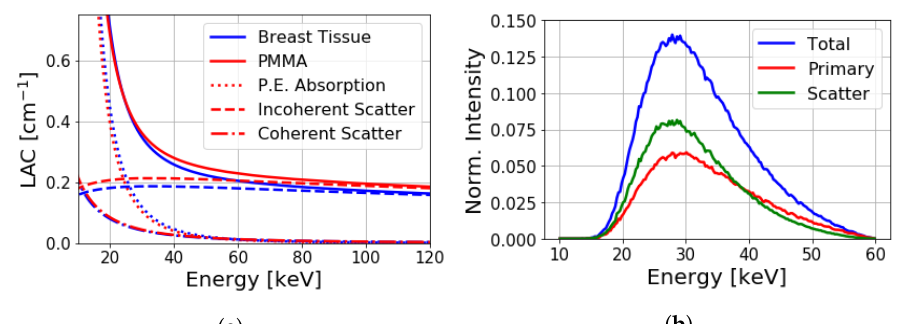
Figure 2. ( a ) Linear attenuation coefficients of breast tissue (blue) and polymethyl methacrylate (PMMA; red). Total linear-attenuation coefficient shown (solid curves) along with photoelectric absorption (dotted curves) and incoherent scatter components (dashed curves). ( b ) Simulated spectral distribution of total, primary, and scattered intensities for a 6.0 cm thick PMMA slab at a 0.5 cm air gap with 60 kVp incidence. Each distribution is normalized by the unattenuated source